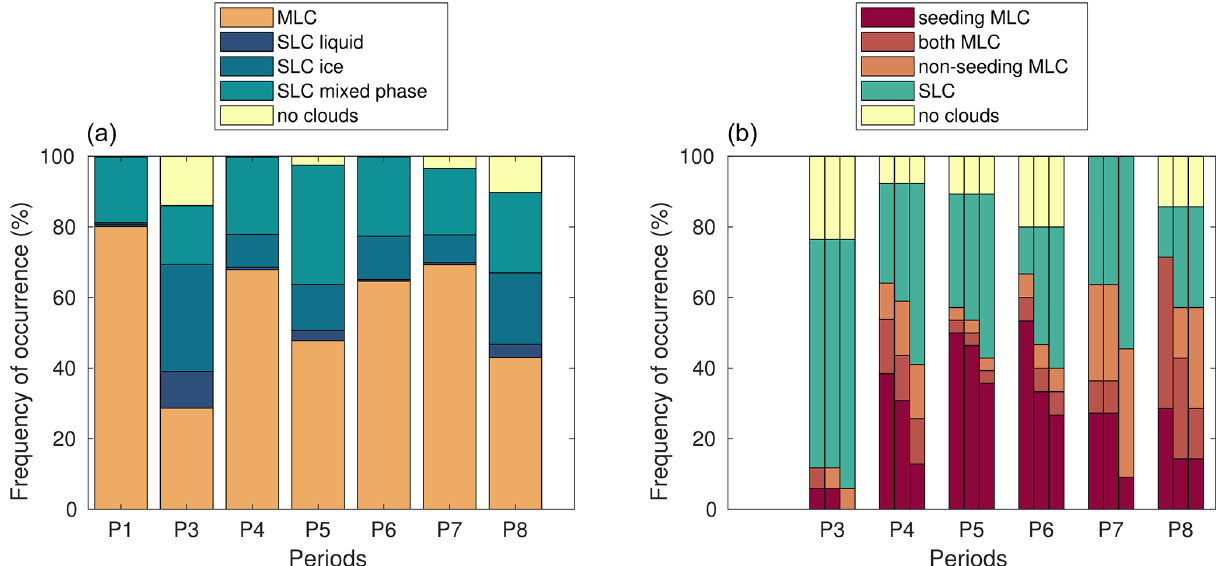
Figure 15. (a) Frequency of occurrence of different types of single-layer clouds (SLCs), multi-layer clouds (MLCs), and no clouds from the Cloudnet results for all available key periods. P2 was excluded from the analysis as no radar data were available. (b) Frequency of occurrence of no clouds, SLCs, and potentially seeding and non-seeding MLCs using the method of Vassel et al. (2019) for assumed ice crystal sizes of 400µm (left), 200µm (middle), and 100µm